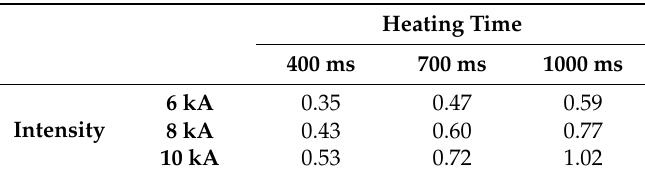
Table 2. Values of the STE (in kJ/g) in function of the intensity (in kA) and heating time (in ms) for the different MF-ERS experiments